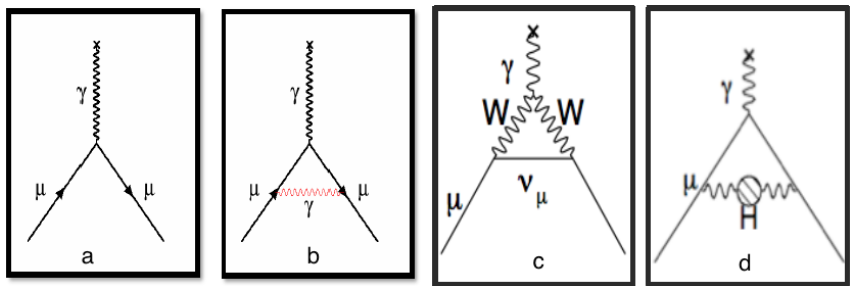
Figure 1. The SM contribution to a µ from: ( a ) the tree-level diagram of the magnetic moment (where g = 2); and the subsequent corrections from: ( b ) QED; ( c ) EW loops; and ( d ) QCD.